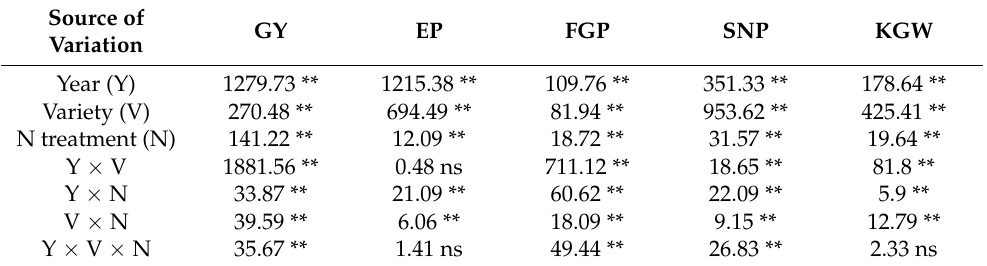
Table 5. Analysis of variance for grain yield, yield components among years, varieties, and N